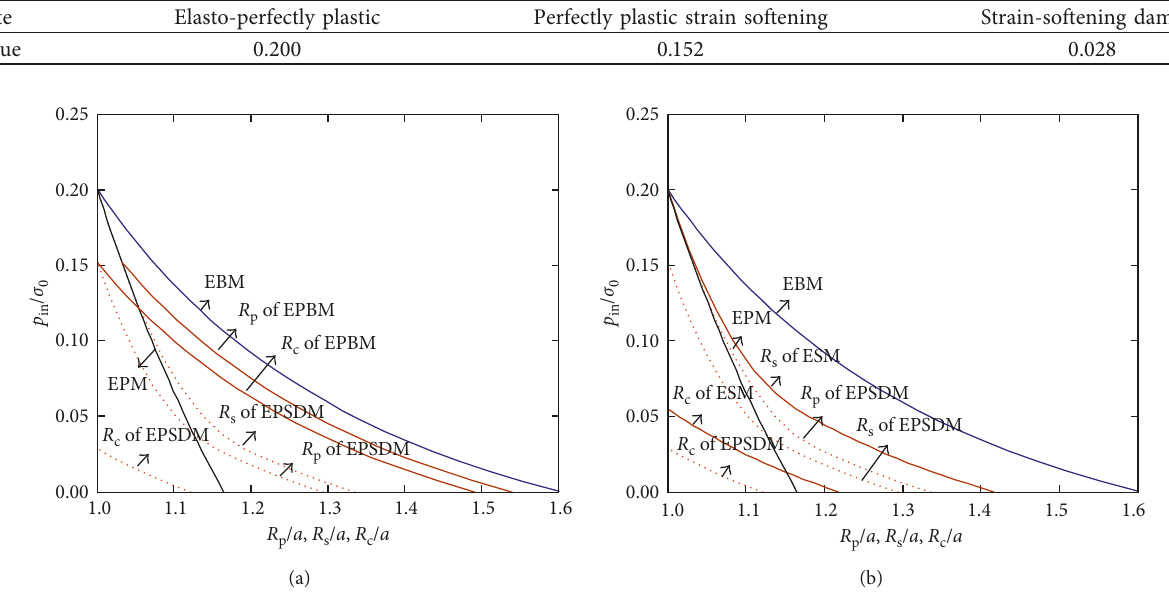
Figure 6: The influence of support resistance on the post-peak failure